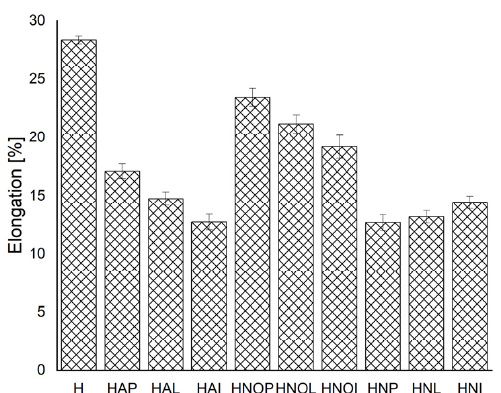
Figure 3. Evolution of elongation values of the experimental 5083 alloy samples, in different struc- tural states.